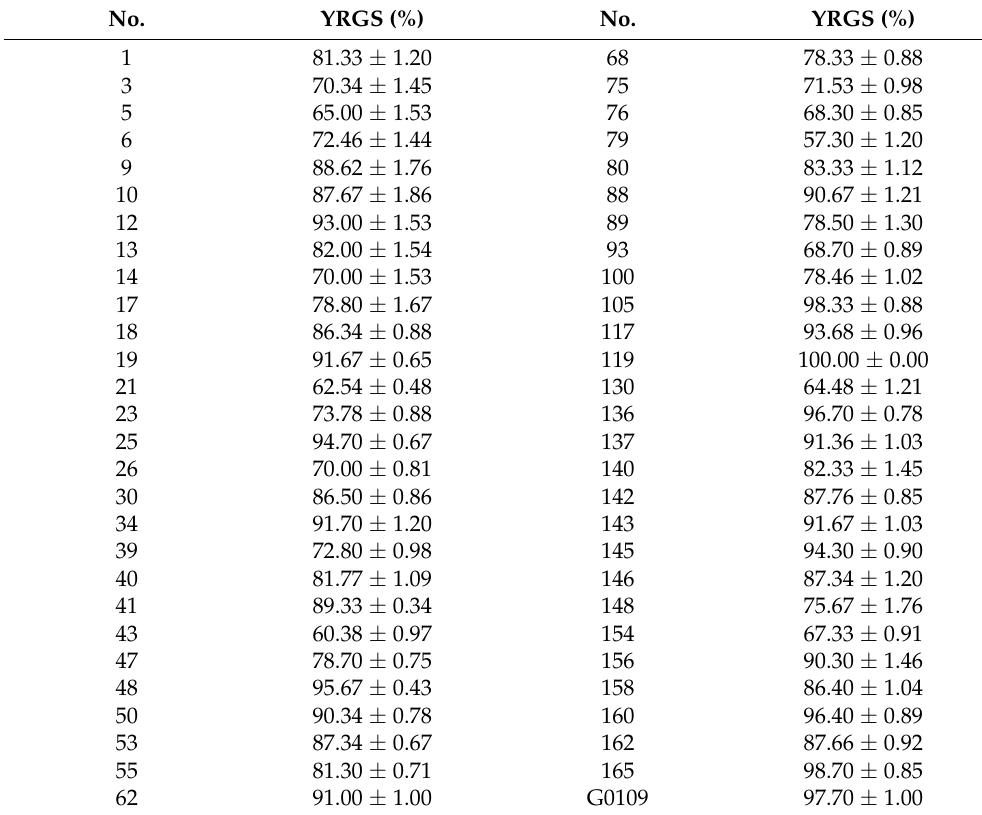
Table 2. Yield ratio of good spawns (YRGS) of spawns originating from mutagenic strains.